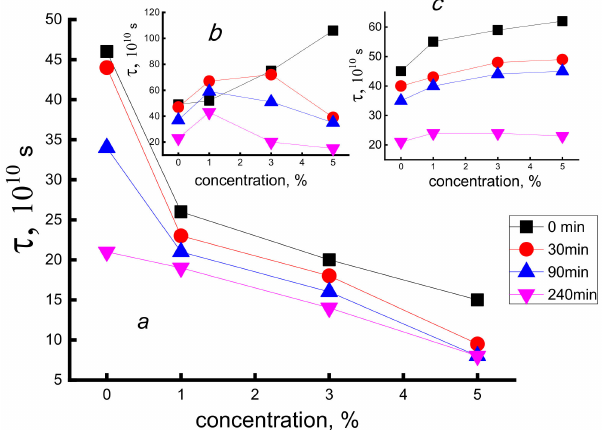
Figure 8. Dependence of time correlation of spin probe on the concentration of SnCl 2 -TPP ( a ), FeCl-TPP ( b ), and TPP ( c ) at a different times of water exposure at 70 ◦ C.